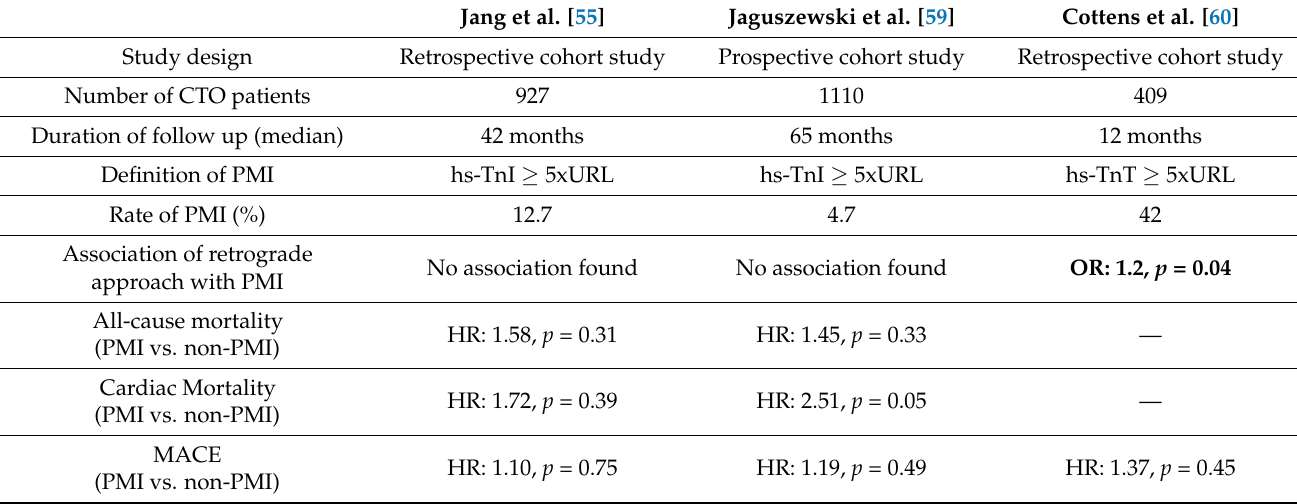
Table 3. Studies without any prognostic impact of CTO-PCI related to newly defined